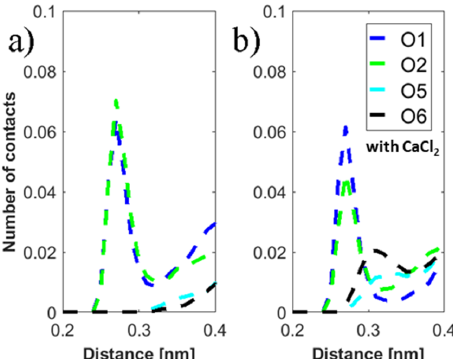
Figure 10. Distribution of distances between the DPPC O4 atom in the phosphate moiety and HA atoms in aqueous: ( a ) NaCl, ( b ) CaCl 2 solutions at 37 °C. This oxygen class of DPPC was chosen since it frequently participates in H-bonds with the classes of atoms in HA as shown in Figure 8. Additionally, carboxyl group atoms (O5 and O6) are presented as calcium ions cause a shift toward the DPPC bilayer.